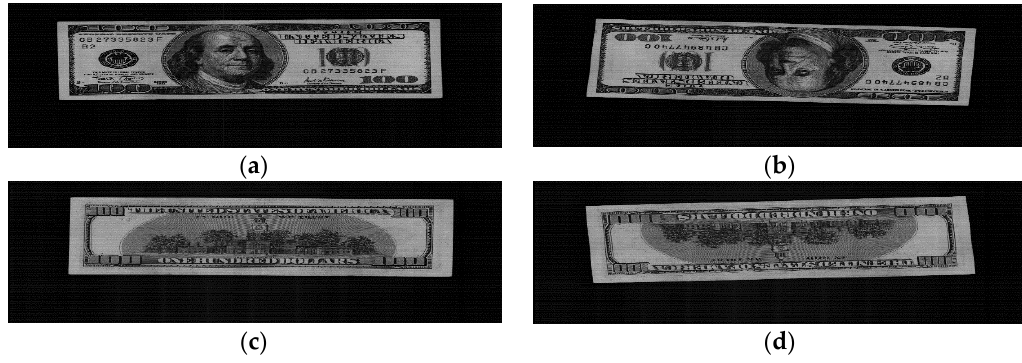
Figure 2. Examples of images of a banknote captured in four directions: ( a ) A; ( b ) B; ( c ) C; ( d ) D.